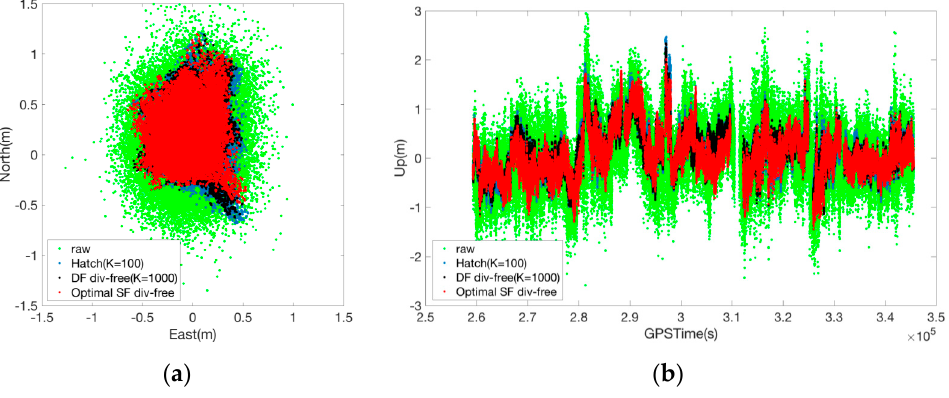
Figure 11. Error distribution for various smoothing filters. ( a ) horizontal; ( b ) vertical. Table 3. Statistics of the position error.